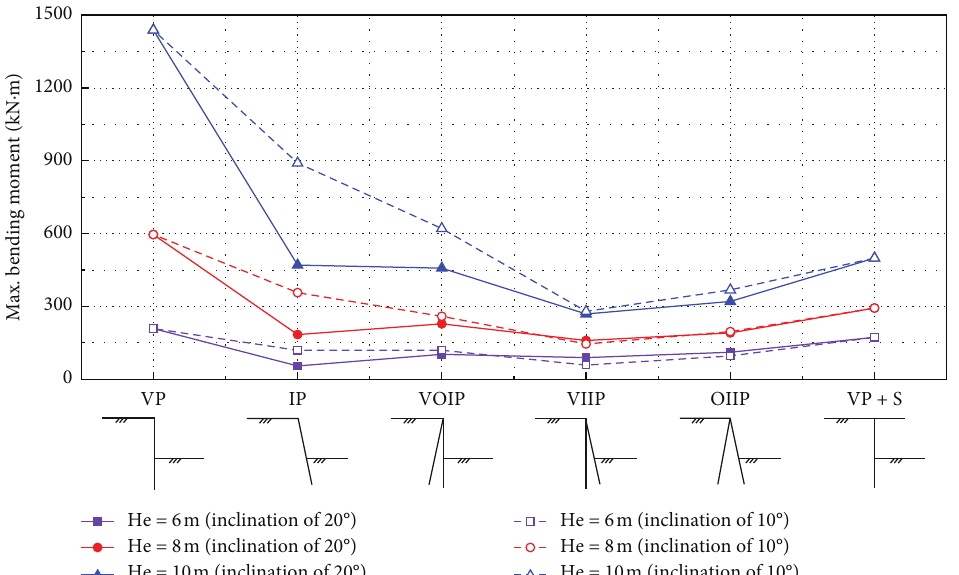
Figure 8: The maximum bending moments of the retaining piles.